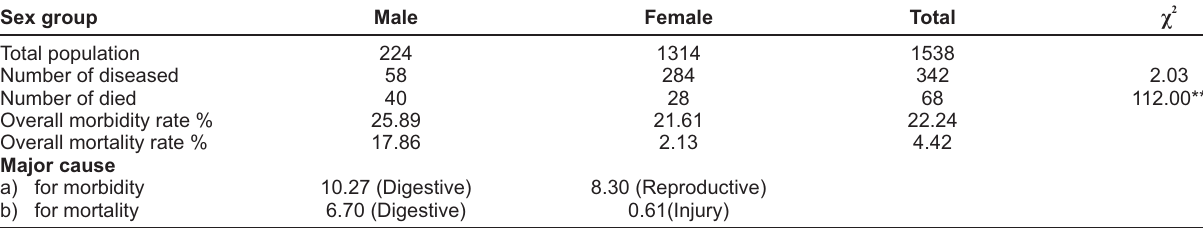
Table-4. Sex-wise morbidity and mortality rates in